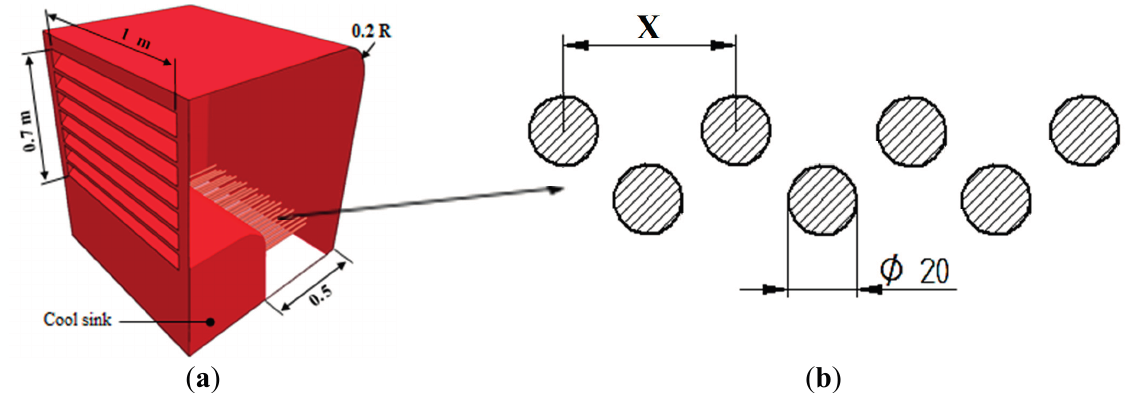
Figure 4. ( a ) Illustration of the computer-aided design (CAD) geometry of the wind tower with heat transfer devices; ( b ) Cross-sectional diagram of the heat transfer device in staggered arrangement.